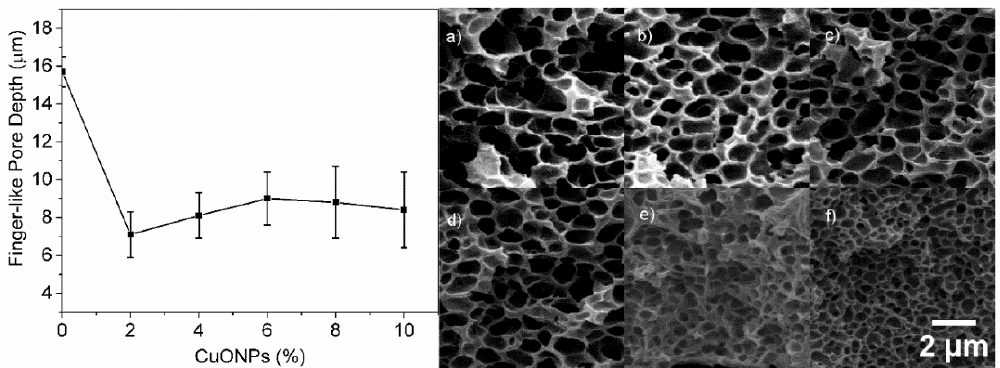
Figure 6. Effect of the CuONP wt % on the depth of the finger-like pores (left panel). SEM micrographs of the sponge-like layer at different CuONP content: ( a ) 0 wt %, ( b ) 2 wt %, ( c ) 4 wt %, ( d ) 6 wt %, ( e ) 8 wt %, and ( f ) 10 wt %. All images have the same size.